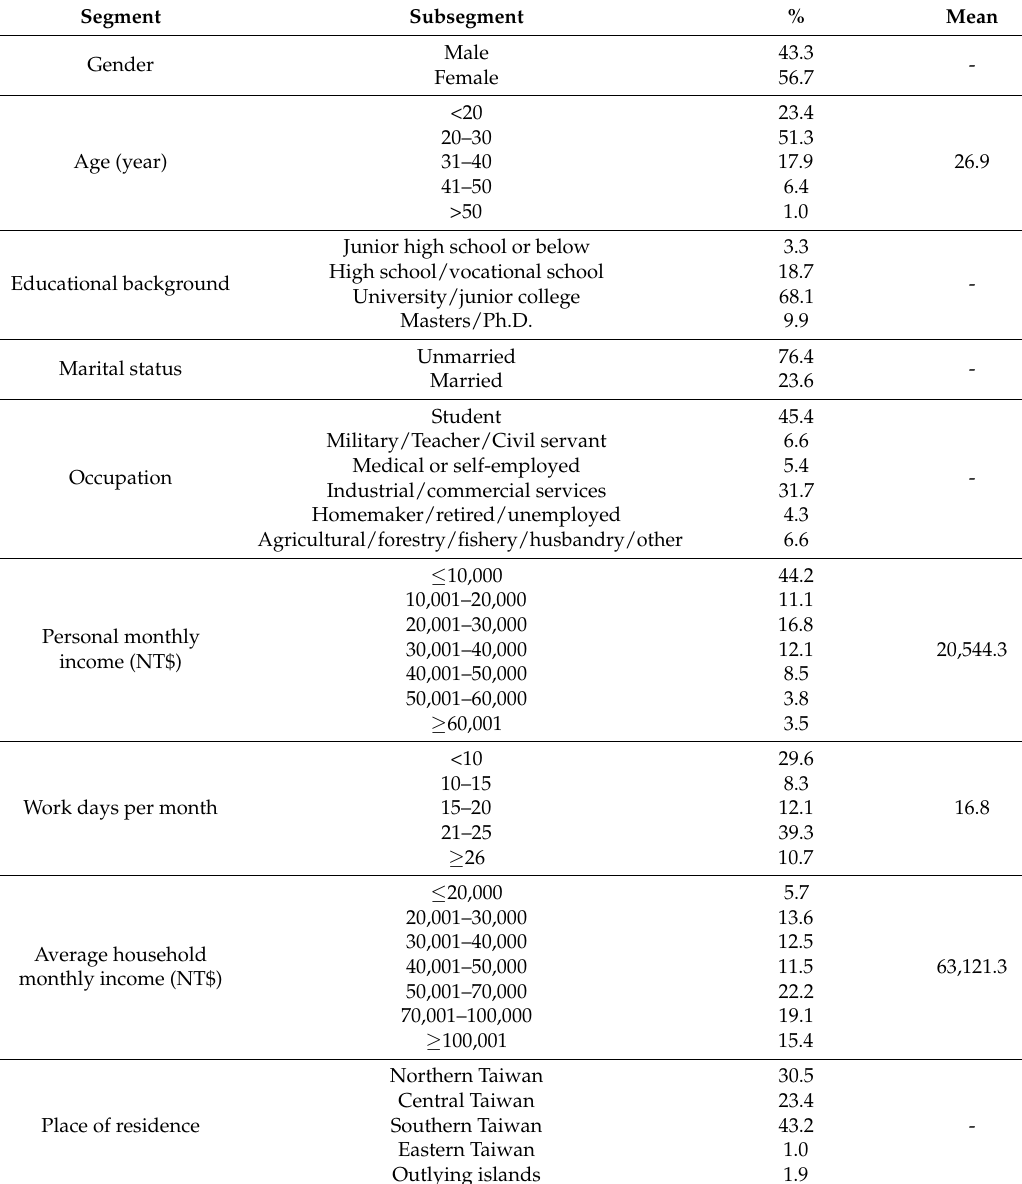
Table 1. Demographic distribution of the